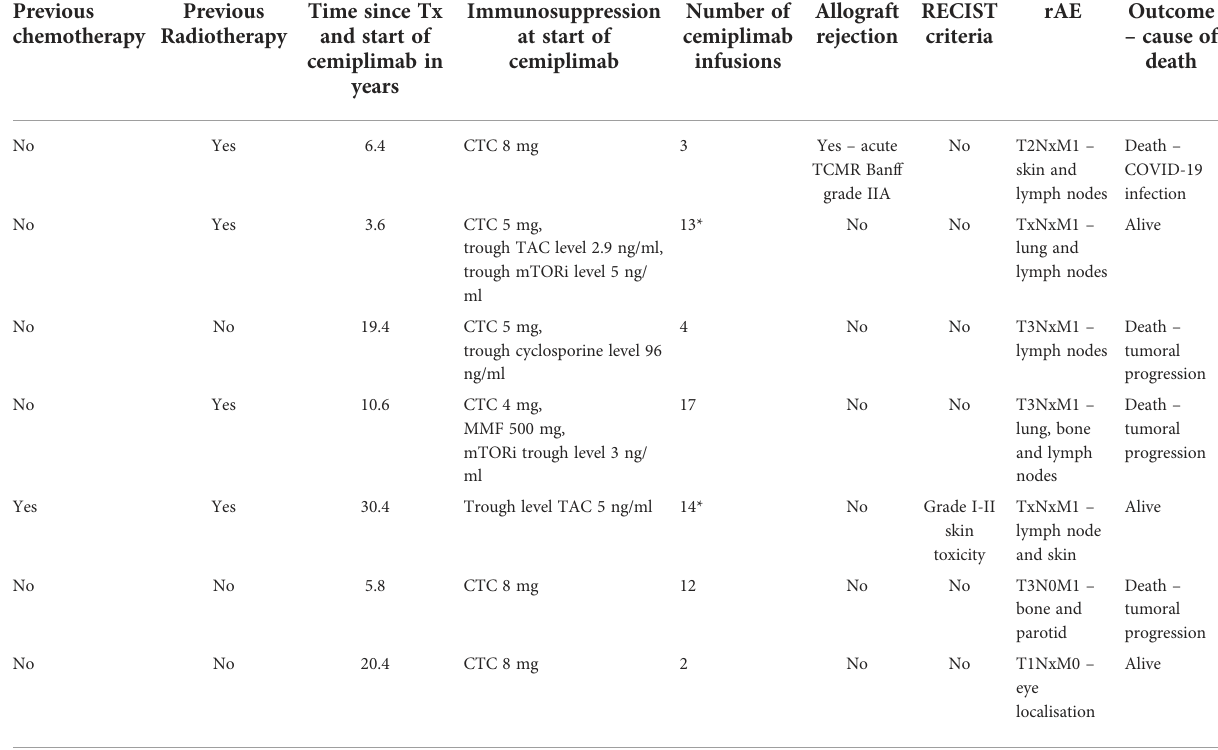
TABLE 2B Details of the characteristics and outcomes of the patients included in the study. Previous